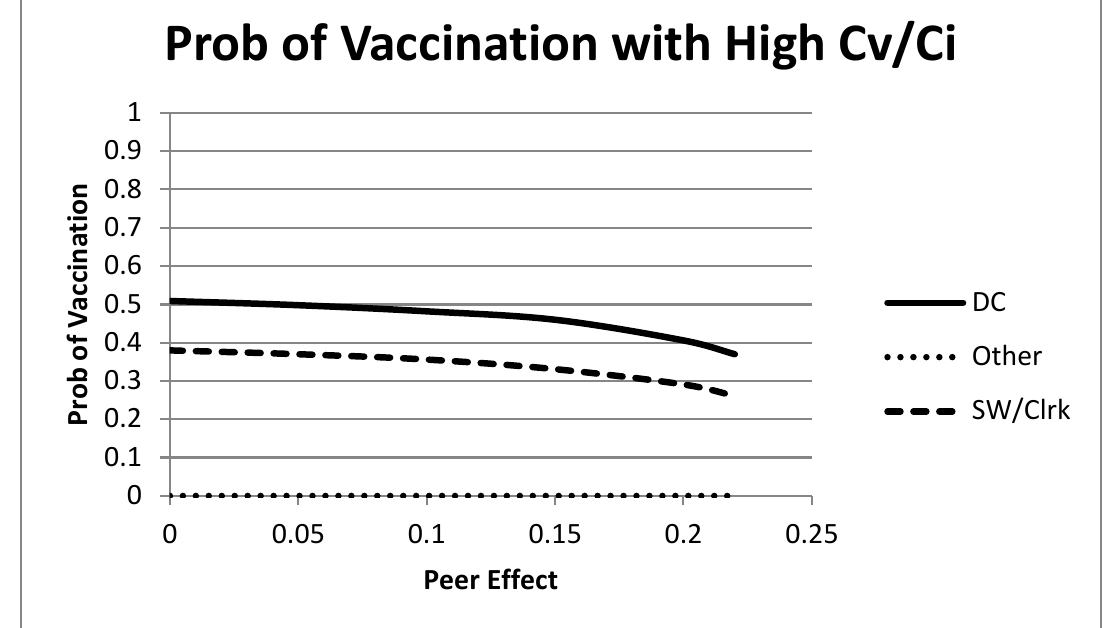
Figure 4. Mixed strategy equilibrium vaccination choices as a function of the size of the peer effects. In this figure, λ is large, λ = 0 . 15 . All groups decrease their equilibrium vaccination rate as peer effects increase.